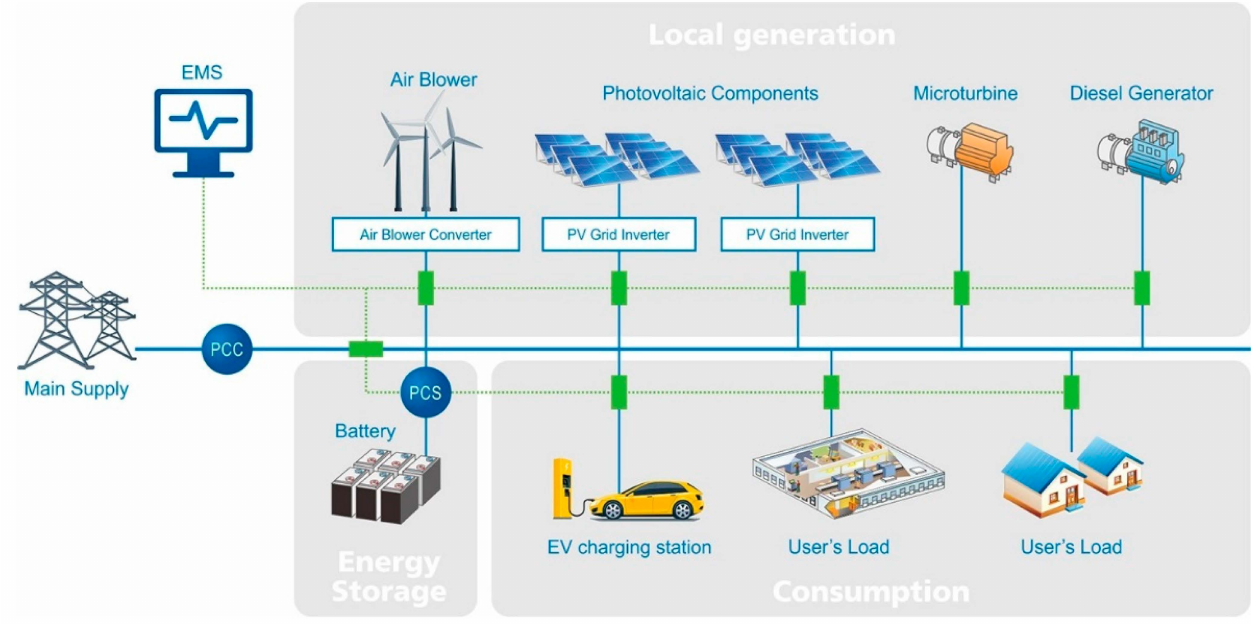
Figure 1. An integrated microgrid system